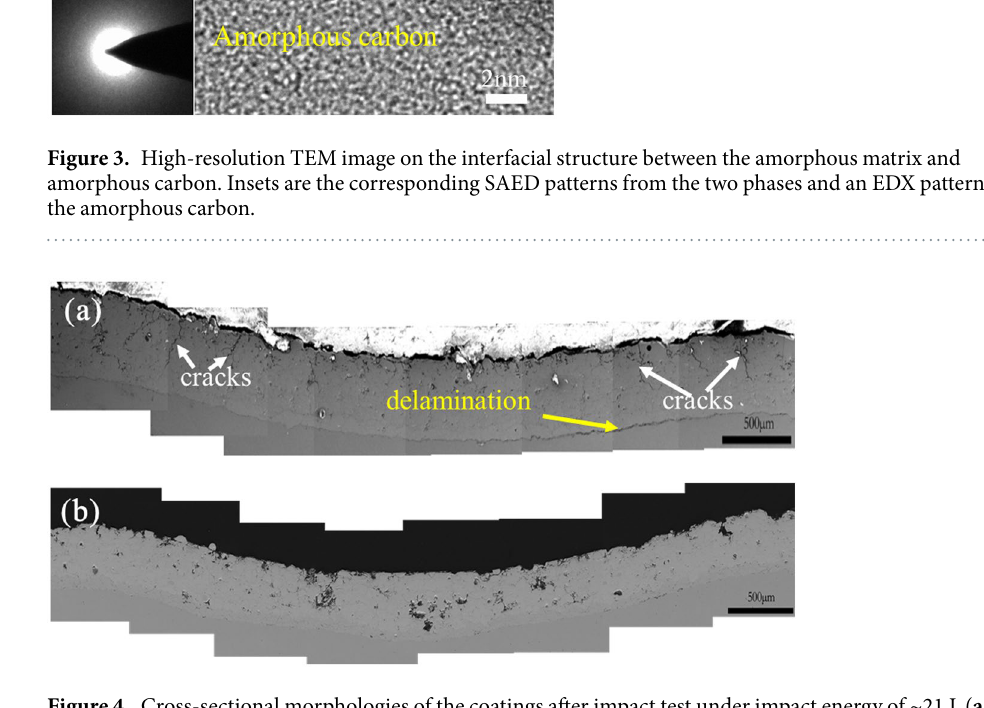
Figure 4. Cross-sectional morphologies of the coatings after impact test under impact energy of ~21 J. ( a ) The amorphous coating and ( b ) the composite coating reinforced by amorphous